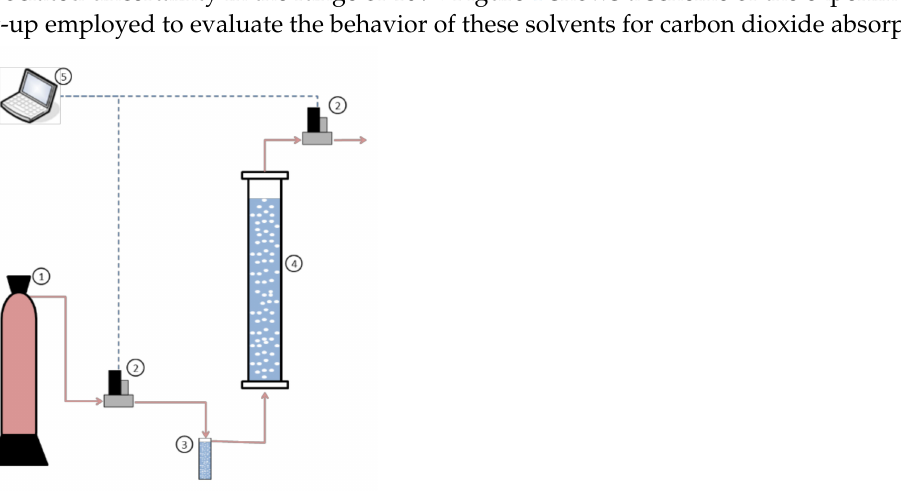
Figure 1. Experimental set-up for carbon dioxide absorption experiments. 1 (cid:13) Gas cylinder, 2 (cid:13) mass flow controllers, 3 (cid:13) gas saturator, 4 (cid:13) bubble column, 5 (cid:13)